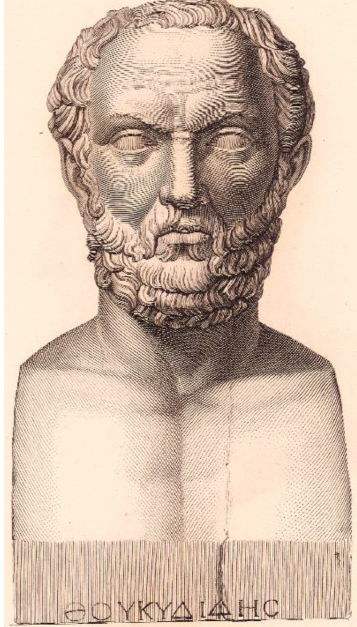
Figure 7. (Thucydides; c. 460–c. 400BC), the Athe- nian historian dubbed the father of scientific history (image source: Visconti,